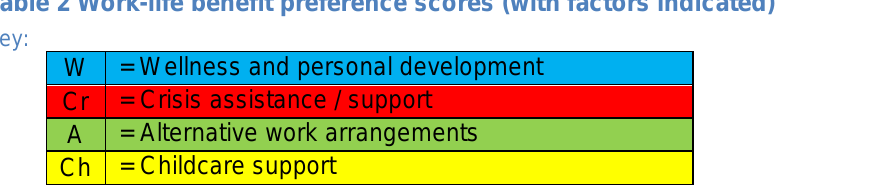
Table 2 Work-life benefit preference scores (with factors